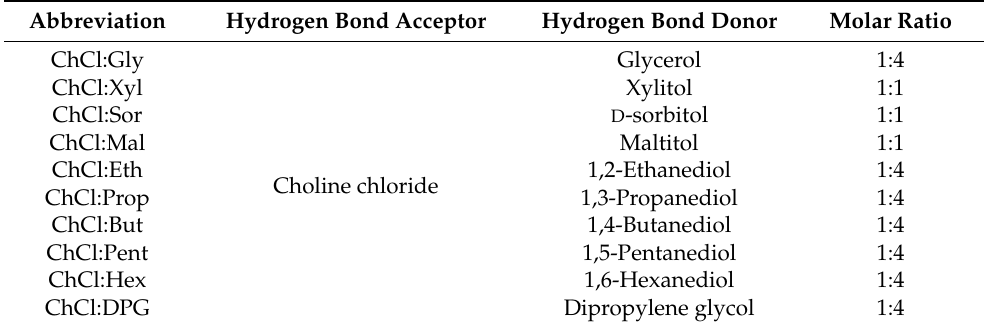
Table 2. List of the choline chloride-based deep eutectic solvents (DESs) synthesized in this